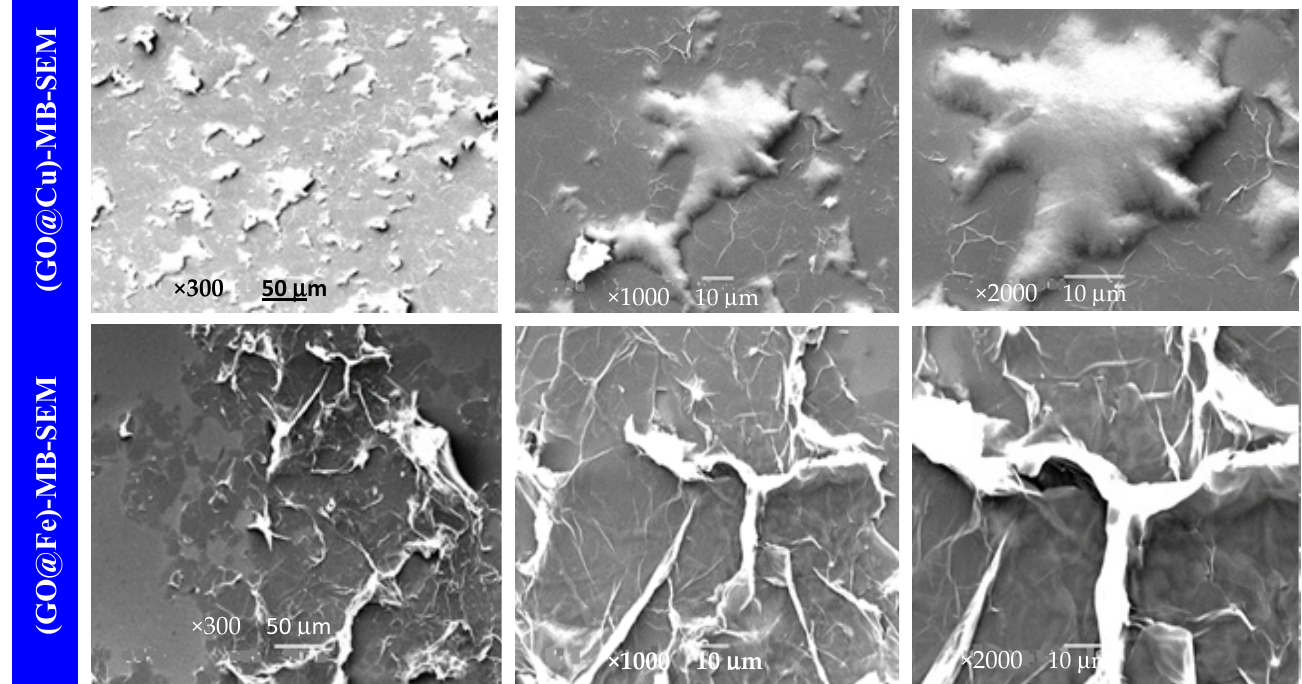
Figure 1. SEM and TEM images for GO @ M composite and SEM images for (GO @ M)-MB complex at various magnifications (M = Cu 2+ or Fe 3+ ).